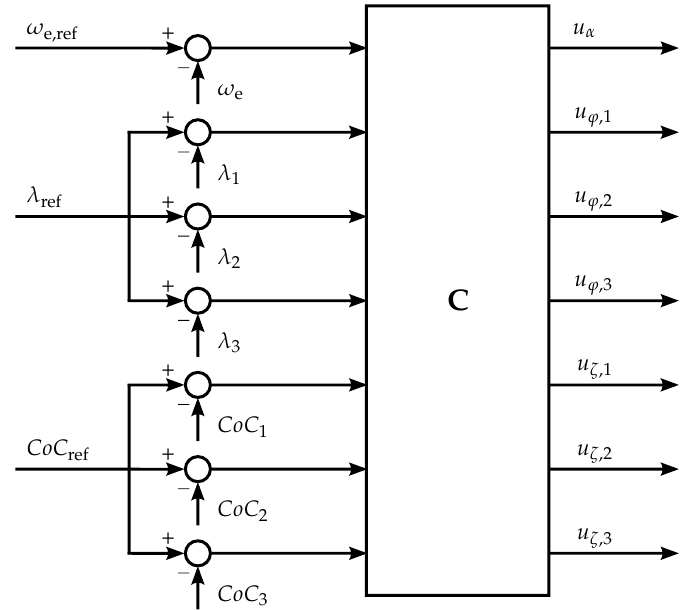
Figure 3. Basic structure of the multivariable